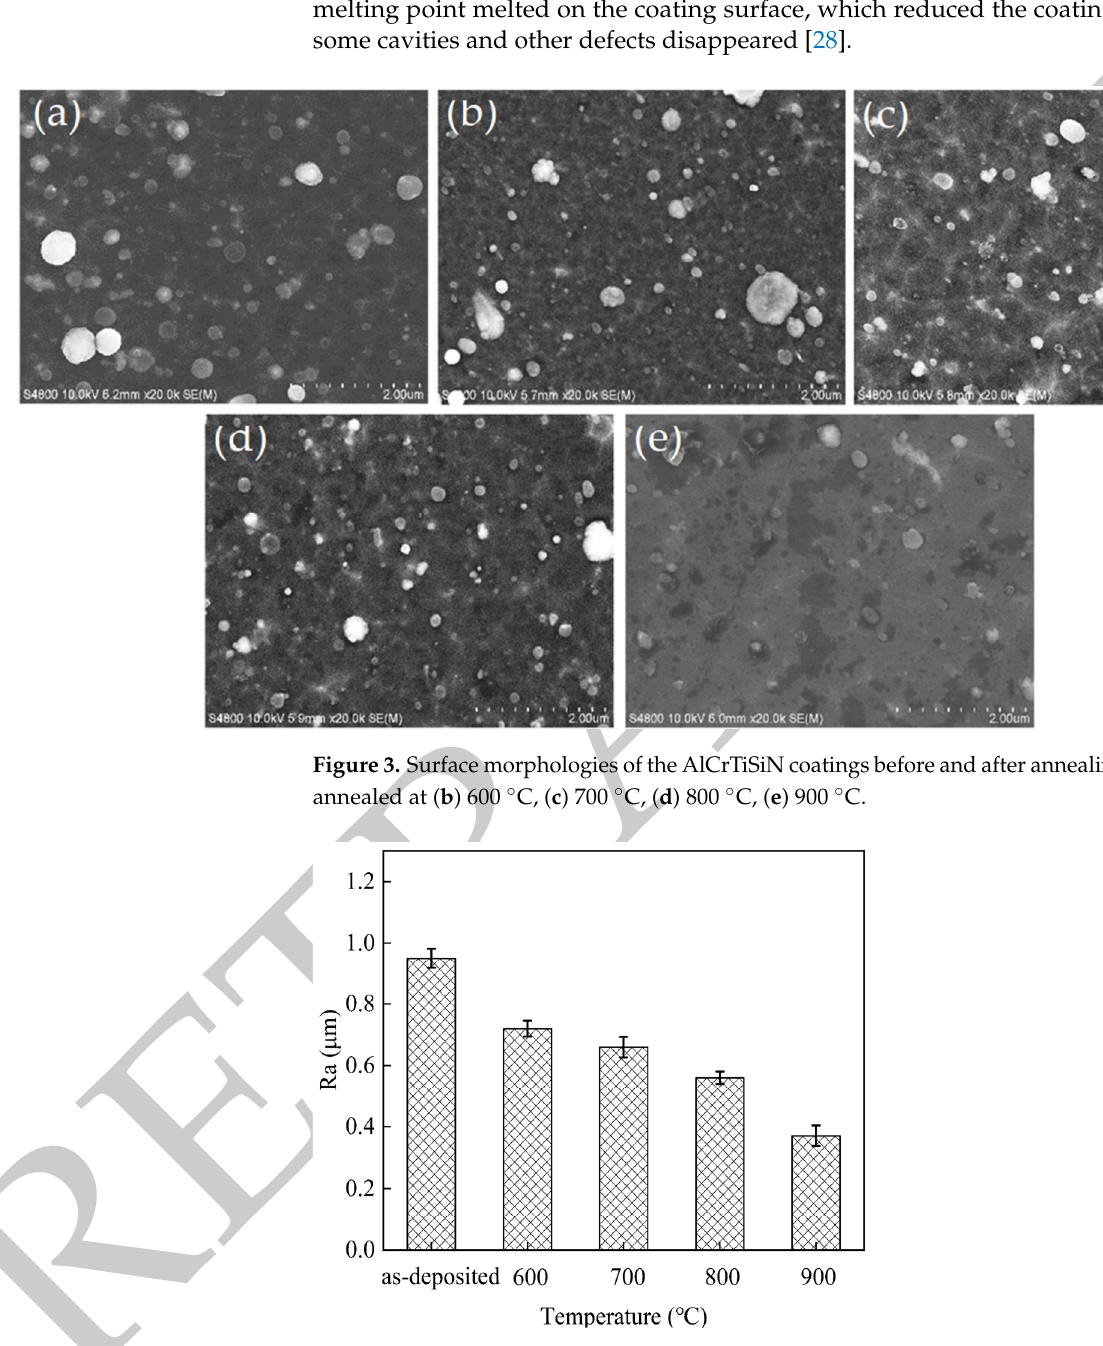
Figure 4. Surface roughness of the AlCrTiSiN coatings before and after annealing at different tem- peratures.